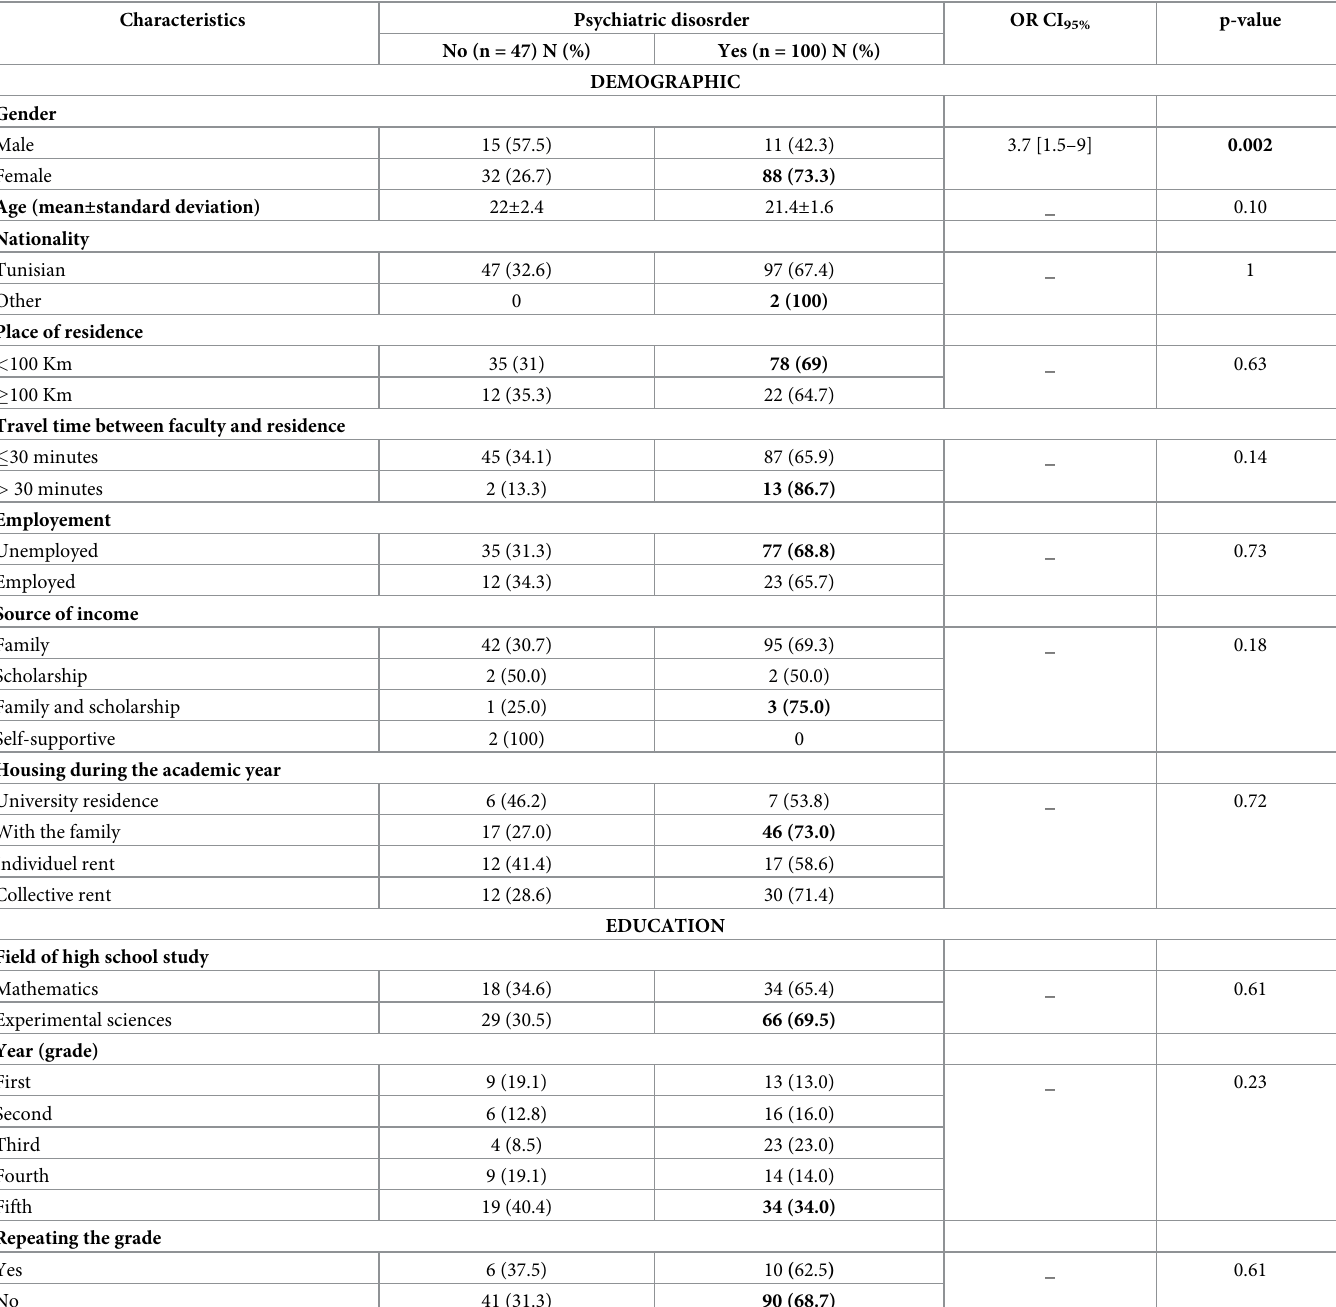
Table 3. Demographic characteristics associated with mental health in medical students, Sousse, Tunisia, 2021.